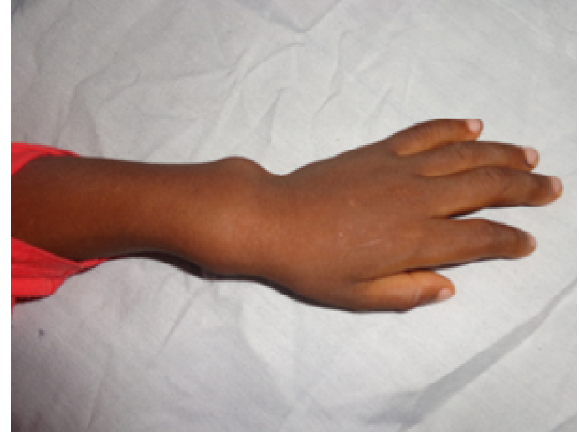
Figure 1. Widening of the wrist.